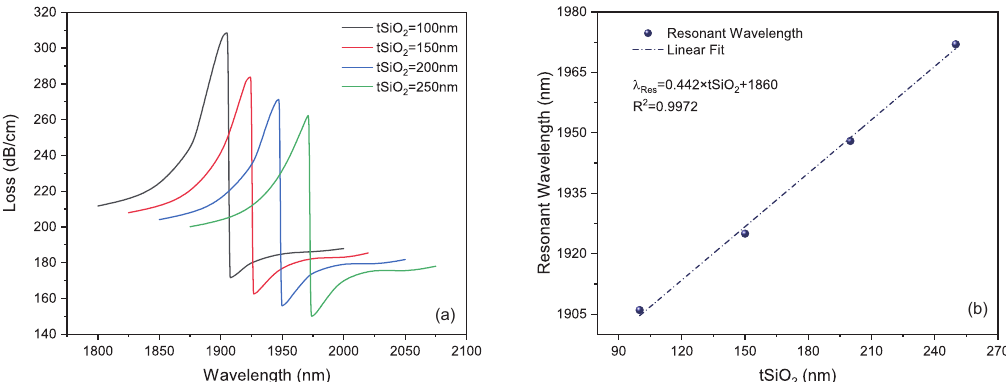
Figure 4. ( a ) The variation of loss spectrum with respect to the change of the silica-web thickness ( Λ = 2600 nm, t SiO = 3 nm, n a = 1.33); ( b ) The dependence between the resonant wavelength and the thickness of the t Au = 70 nm, t TiO 2 silica web.